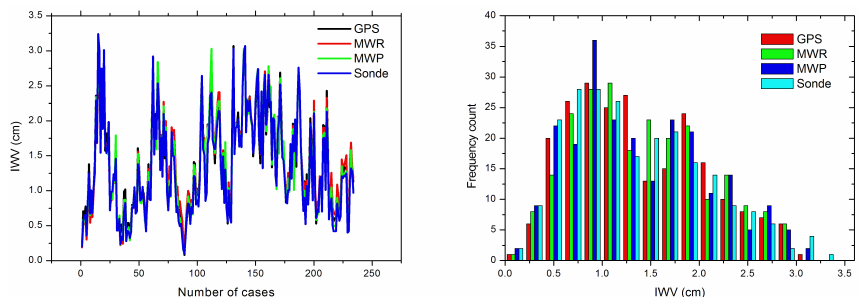
Figure 2. Example of the time series (left) of integrated water vapour obtained with the instruments available at the Lindenberg site (reported in Table 1) and histograms (right) of the time series shown in the left panel. After detrending of the time series, the histograms were used to calculate entropy and mutual correlation.